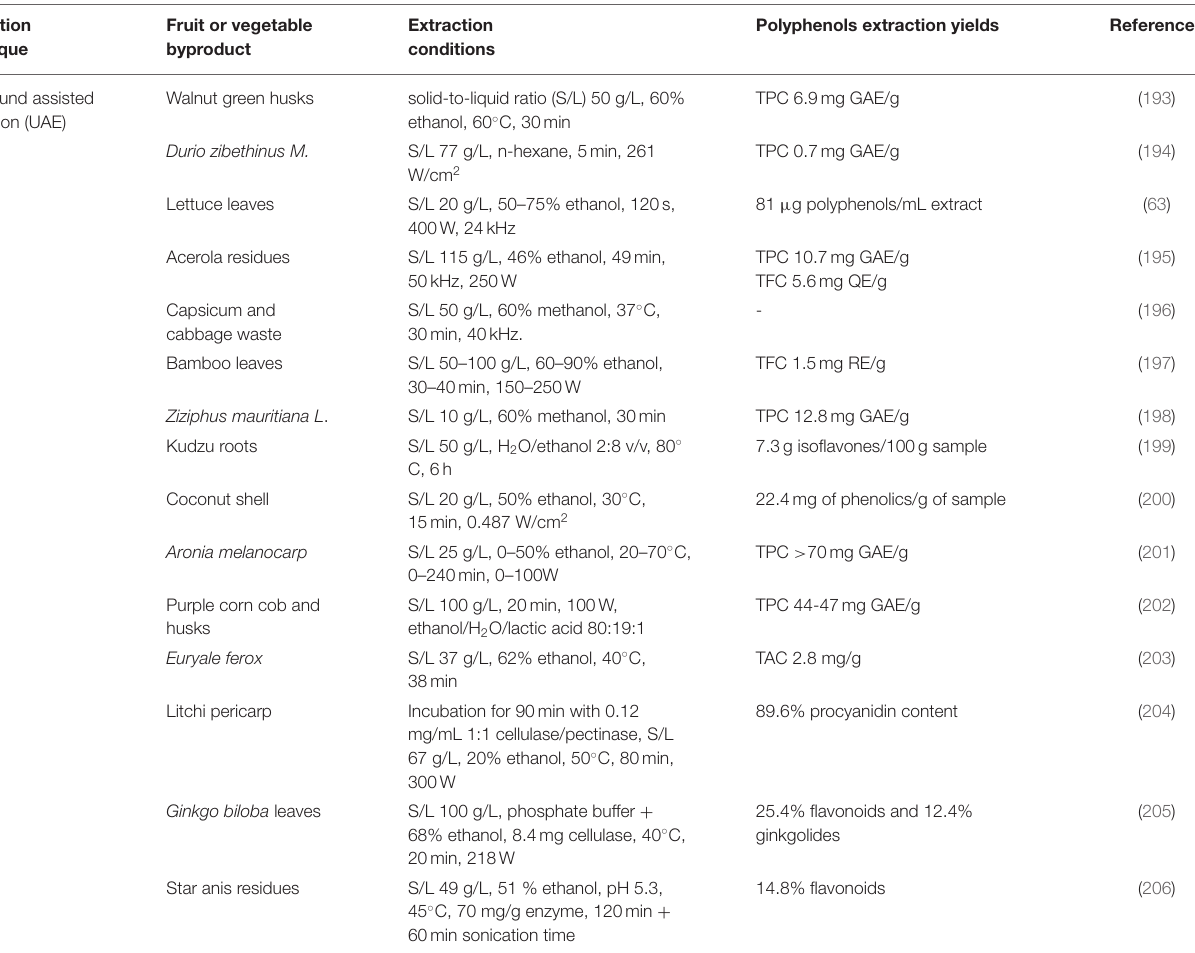
TABLE 2 | UAE extraction of phenolic compounds from various agri-food